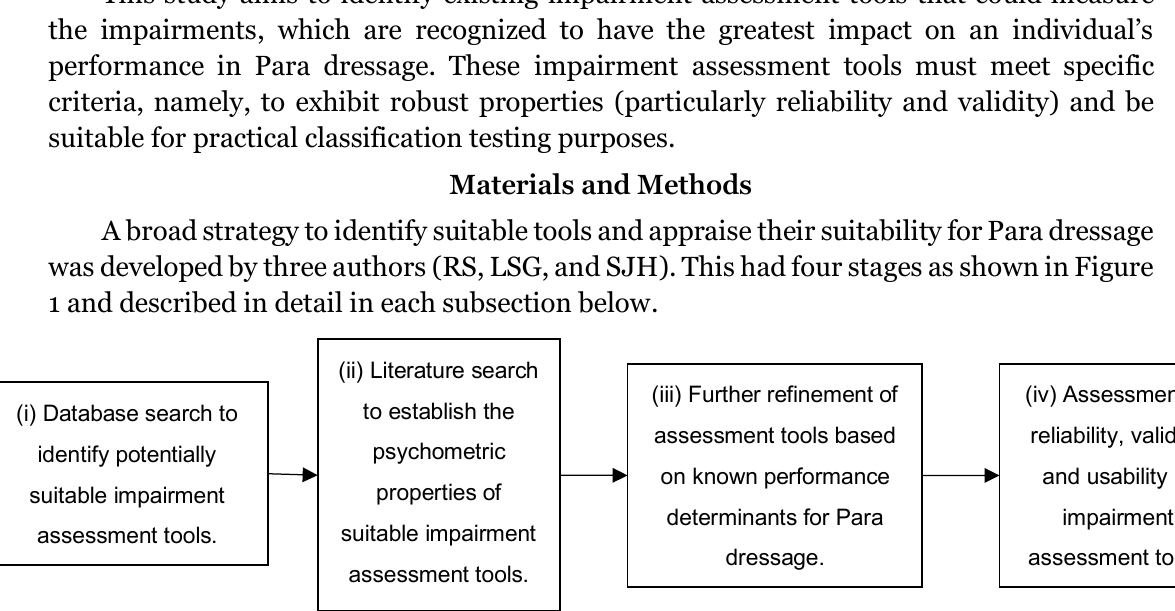
Figure 1. Stages of the